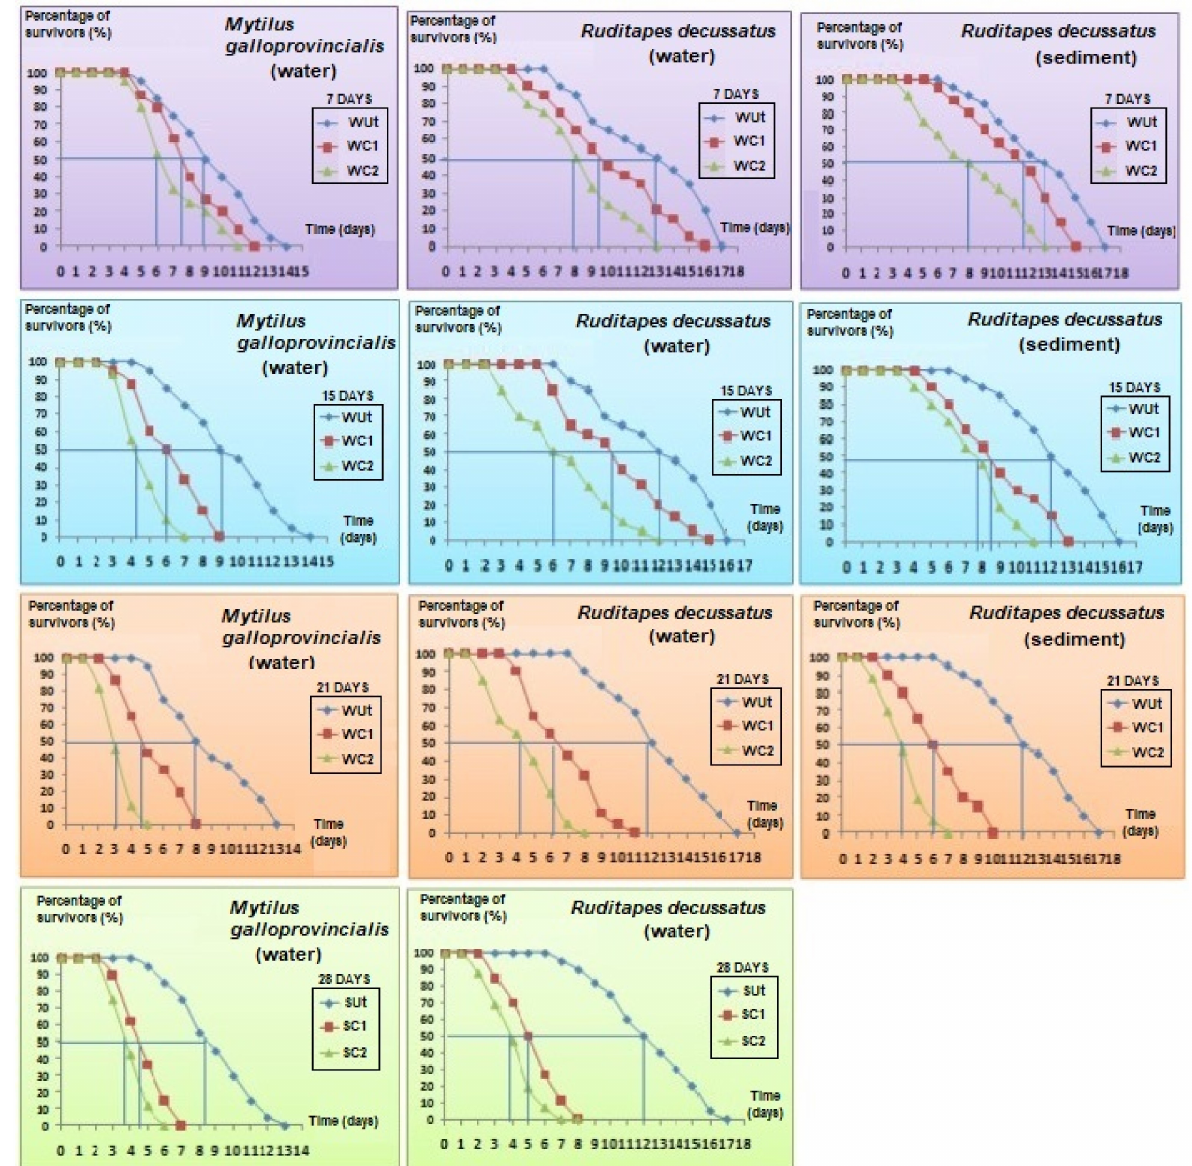
Figure 4. Percentage of survivors in bivalves’ species Mytilus galloprovincialis and Ruditapes decussatus in open air after being exposed to an Untreated control (Ut) and two concentrations of phenanthrene in water [50 µ g/L (WC1) and 100 µ g/L (WC2)] and sediment [50 µ g/kg (SC1) and 100 µ g/kg (SC2)] over 28